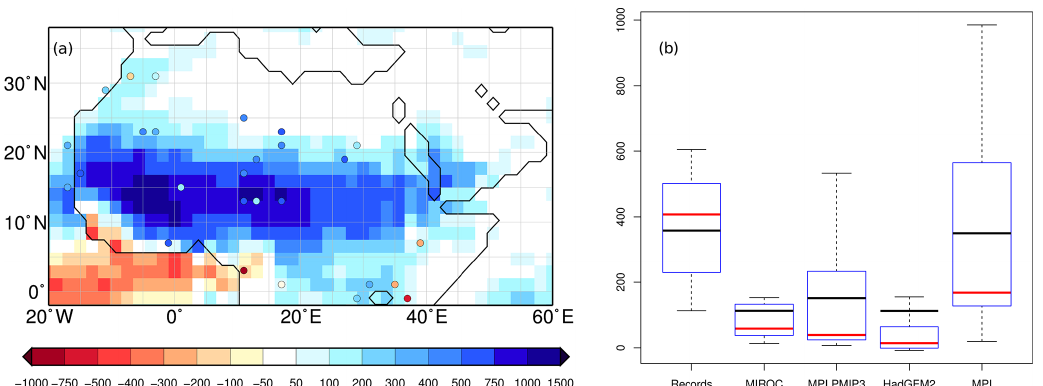
Figure 2. (a) Simulated (shaded) and reconstructed (dots; Bartlein et al., 2011) difference in annual mean precipitation (mmyr − 1 ) between 6ka and and (b) boxplot of the annual mean precipitation difference (mmyr − 1 ) between 6ka and PI based on all available records north of 10 ◦ N (Bartlein et al., 2011; cf. Braconnot et al., 2012) and the grid cells in the different models, in which the sites of these records are located. Considered are the PMIP3 models including dynamic vegetation (MIROC, MPI.PMIP, HadGEM2) and the model used in this study (MPI). Also shown are the mean (black line) and the median (red